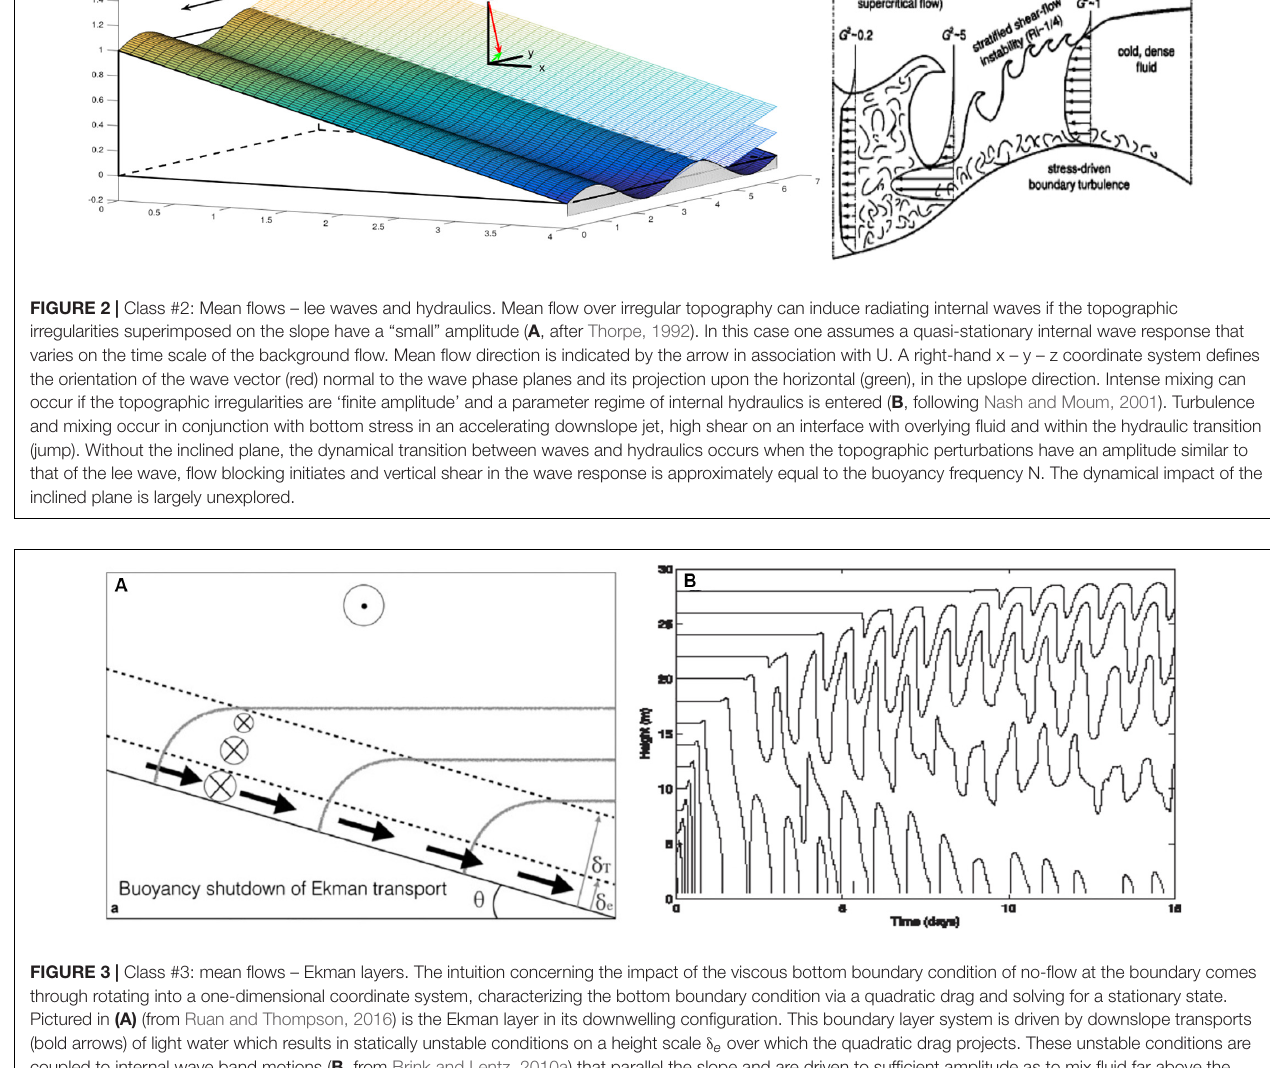
constrained to simulate processes occurring either at and